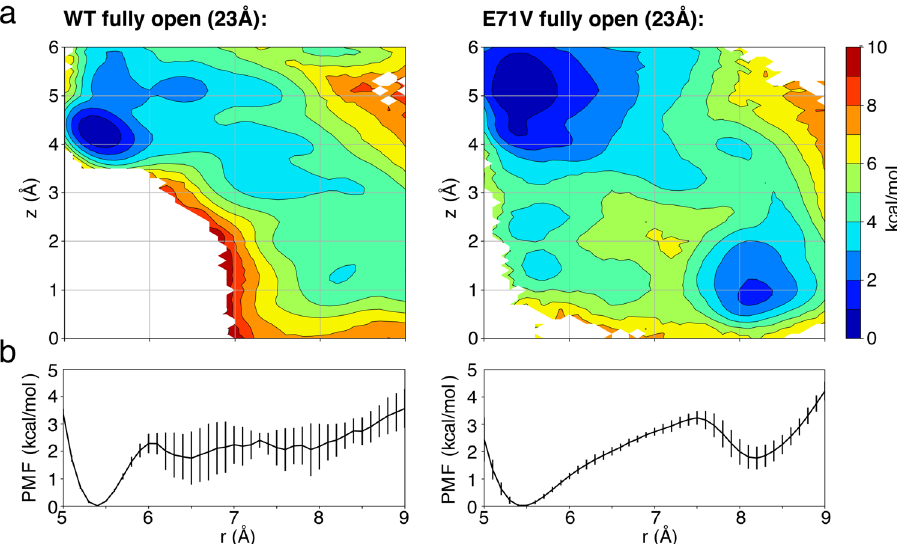
Fig. 9 Free energy landscapes to assess the conformational preferences of the selectivity fi lter of WT and the E71V KcsA mutant as a function of intracellular gate opening. a 2D PMF depending on two coordinates. The horizontal reaction coordinate r describes the width of the selectivity fi lter and is de fi ned as the average cross-subunit pinching distance between the C α atoms of G77. The vertical reaction coordinate z indicates the position of the external K + ion along Z axis relative to the center of the selectivity fi lter. Extensions of previous calculations 29,32 . b 1D PMF projected along the horizontal reaction coordinate r (after Boltzmann integration of the vertical reaction coordinate z